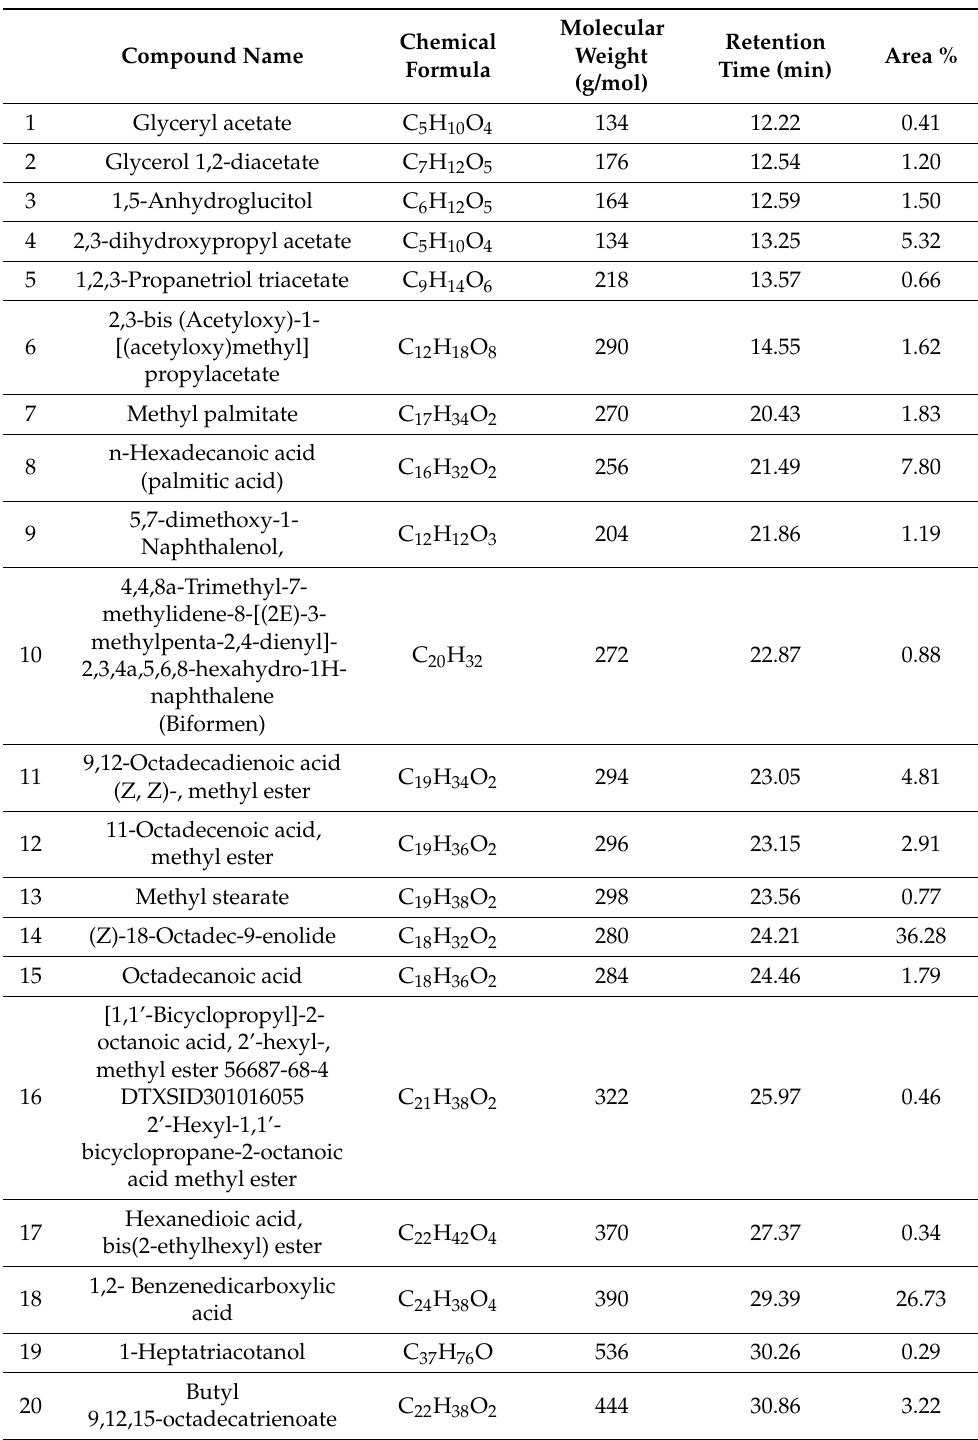
Table 5. The metabolites identified in the P. chrysogenum MZ945518’s ethyl acetate